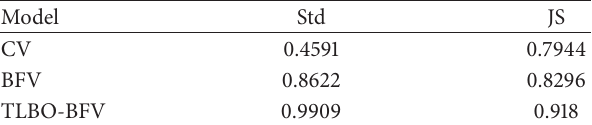
Table 1: Results of Figure 2.